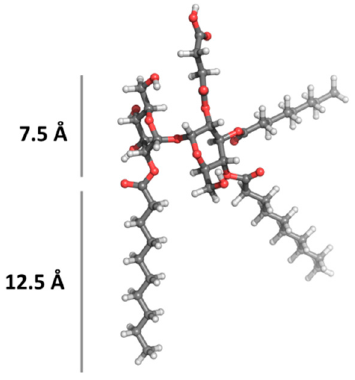
Figure 4. Optimized structure of TL. Molecular modeling was performed as described in the text.